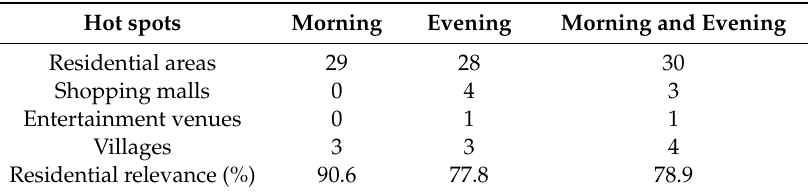
Table 1. Statistics of hot spot types for di ff erent data sets. Hot